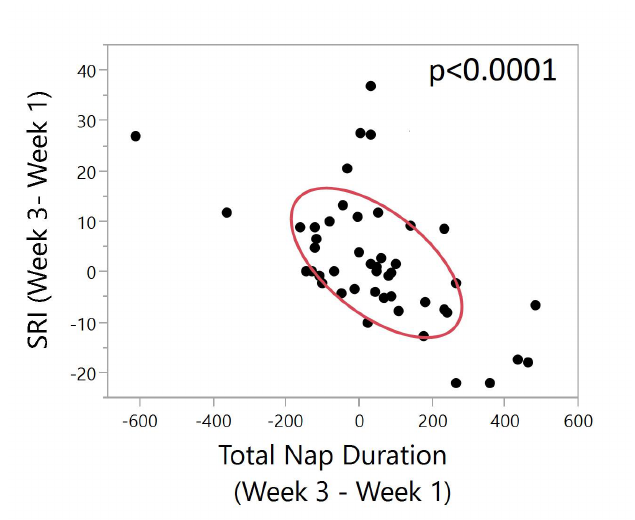
Figure 4. Bivariate plot of SRI (week 3–week 1) vs. total nap duration (week 3–week 1). The red ellipse shows a graphical indicator of the correlation between two di ff erences. The red ellipsoid collapses diagonally as the correlation between them approaches either 1 or − 1. The ellipsoid is more of a circle and less of a diagonal if the two variables are less correlated. The ellipse is encircling 50% of the points on the plot. A significant negative correlation is shown (Pearson, N = 46, ρ = − 0.59, p < 0.0001) between the two di ff erences. This can be interpreted as a higher SRI di ff erence between week 3 and week 1 indicates improved sleep regularity between week 3 and week 1. A higher di ff erence in total nap duration indicates increased napping time between week 3 and week 1. Significant negative correlation shows that with increased sleep regularity, there is a lower total nap duration between the two time points.